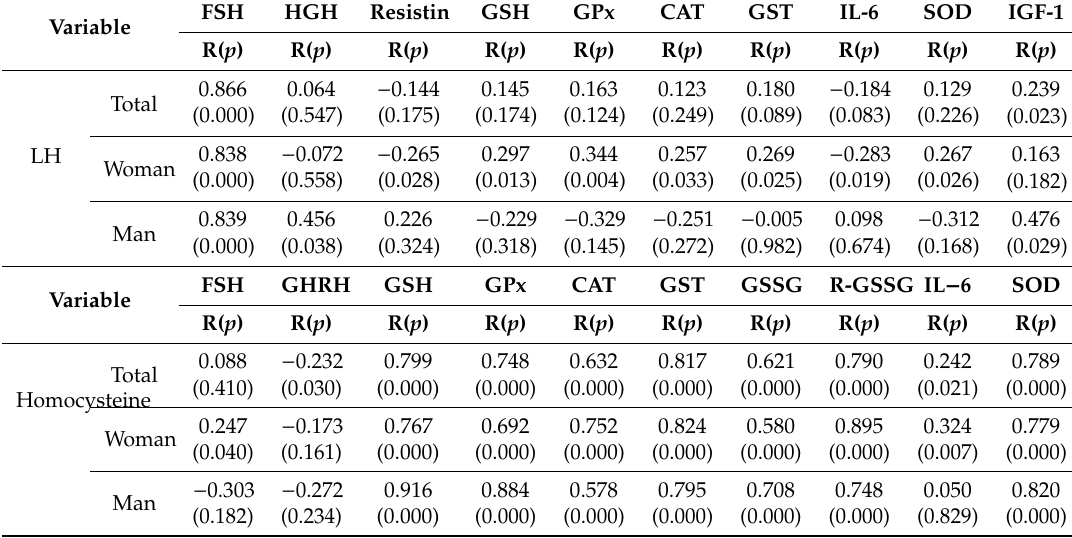
Table 4. Spearman rank correlation analysis for luteinizing hormone (LH) and homocysteine, including selected variables in the general group, men and women.